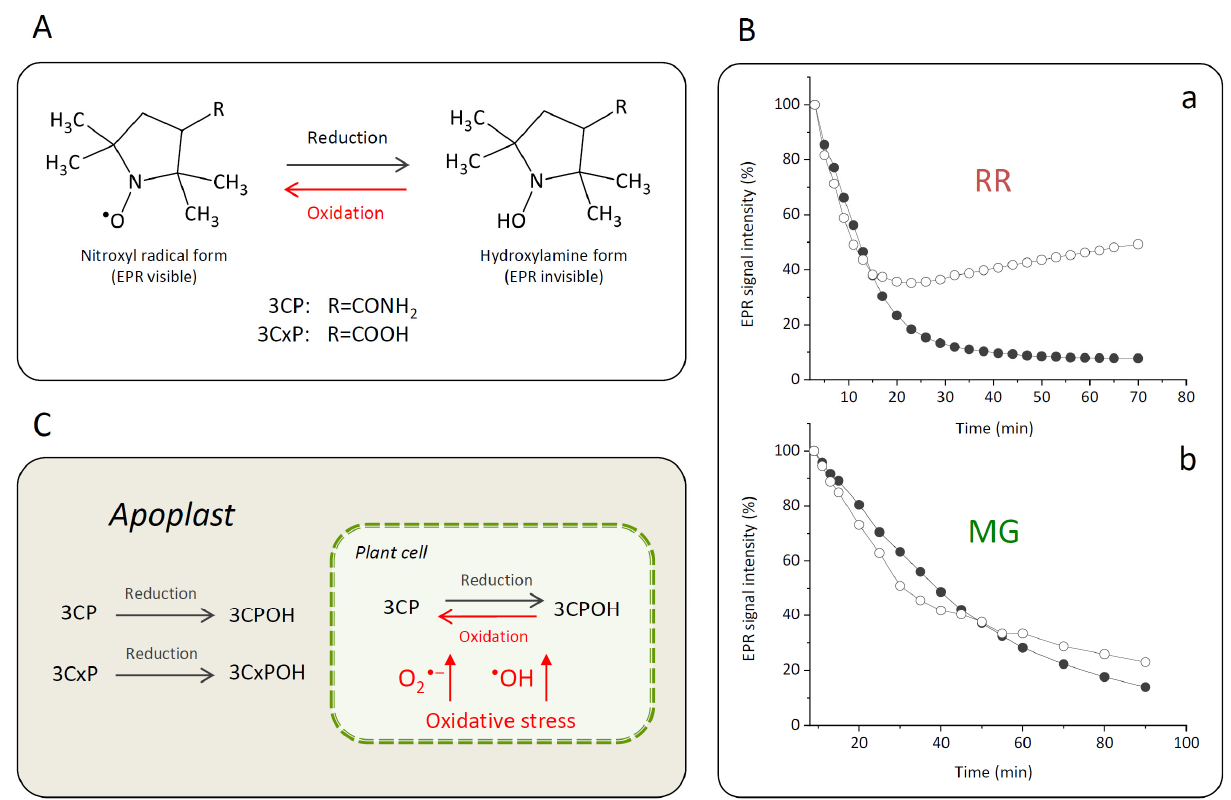
Figure 5. ( A ) Reversible one-electron reduction–oxidation showing the interconversion between the nitroxide 3CP and 3CxP spin probes (EPR visible) and corresponding reduced hydroxylamine forms 3CPOH and 3CxPOH (EPR invisible). ( B ) Kinetics of change of the EPR signal intensity of spin probes 3CP (white circles) and 3CxP (black circles) in strips of RR ( a ) and MG ( b ) bittersweet fruits adopting the X-band 1D gradient EPRI technique. ( C ) Proposed mechanism of the 3CP and 3CxP reduction–oxidation as influenced by the oxidative stress in bittersweet fruits and their localization in the cellular